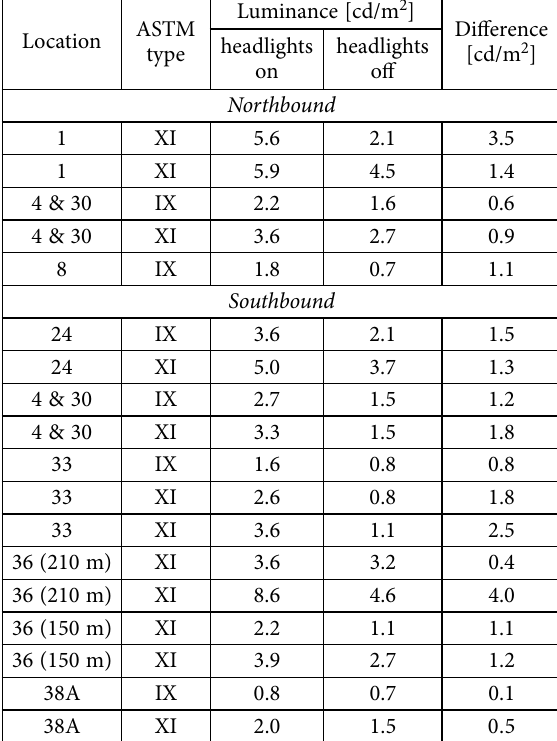
Table 2. Summary of photometric